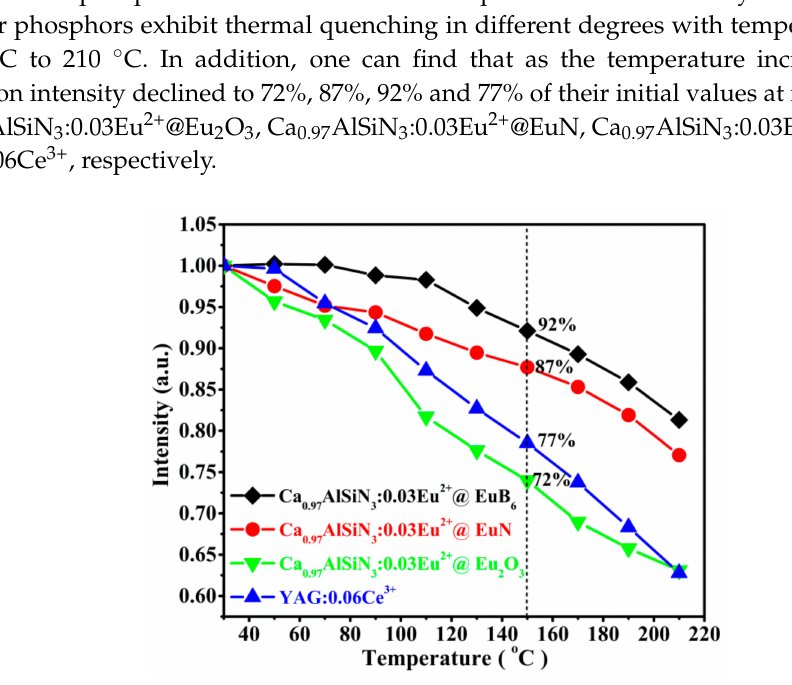
Figure 8. Temperature-dependent emission intensities of Ca 0.97 AlSiN 3 :0.03Eu 2+ @Eu 2 O 3 (green line), Ca 0.97 AlSiN 3 :0.03Eu 2+ @EuN (red line), Ca 0.97 AlSiN 3 :0.03Eu 2+ @EuB 6 (black line) and YAG:0.06Ce 3+ (blue line)